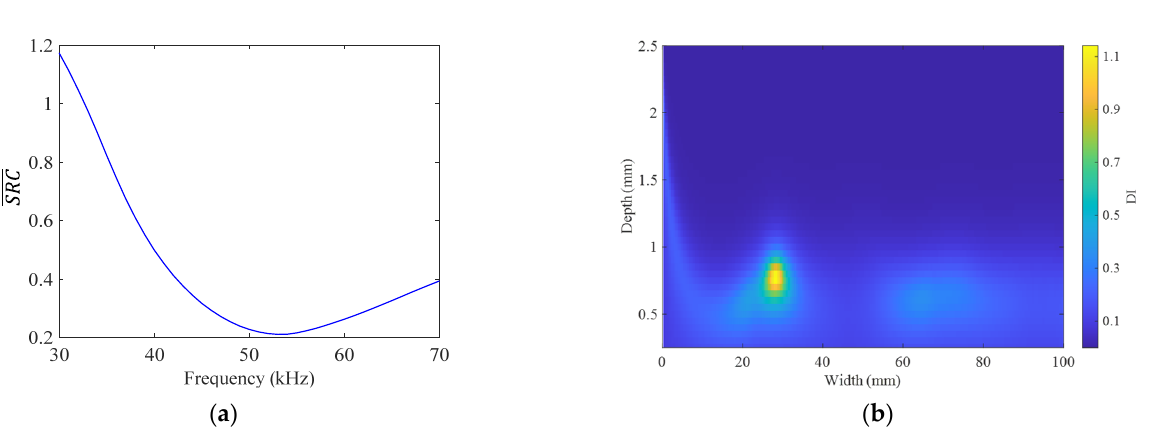
Figure 11. ( a ) The received signal and ( b ) its complex Morlet wavelet transform result for the first damage case.